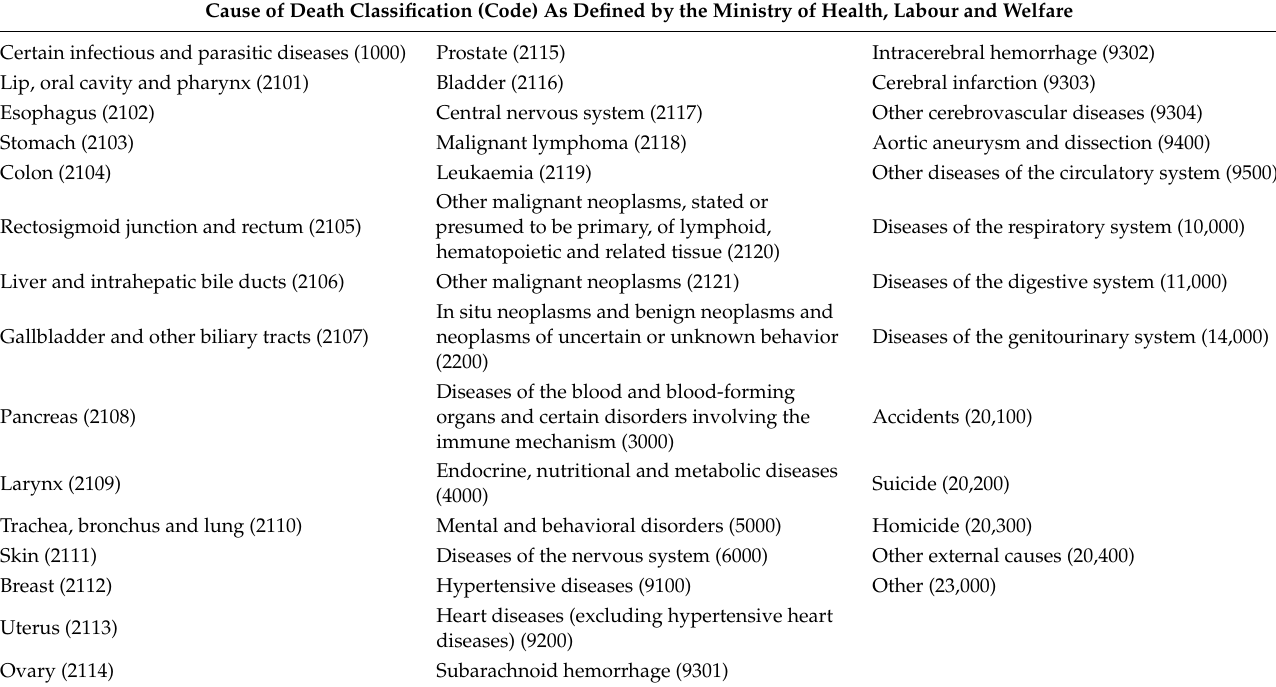
Table A1. Cause of death classification (code).